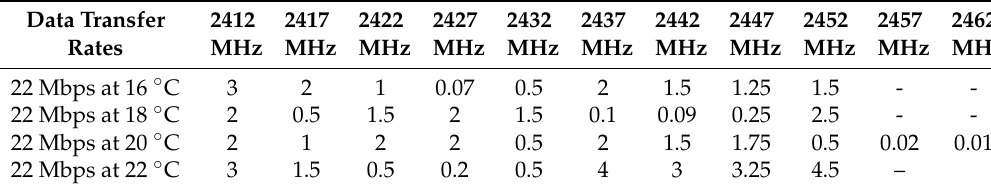
Table 15. Calculation of residuals for OFDM at 22 Mbps.